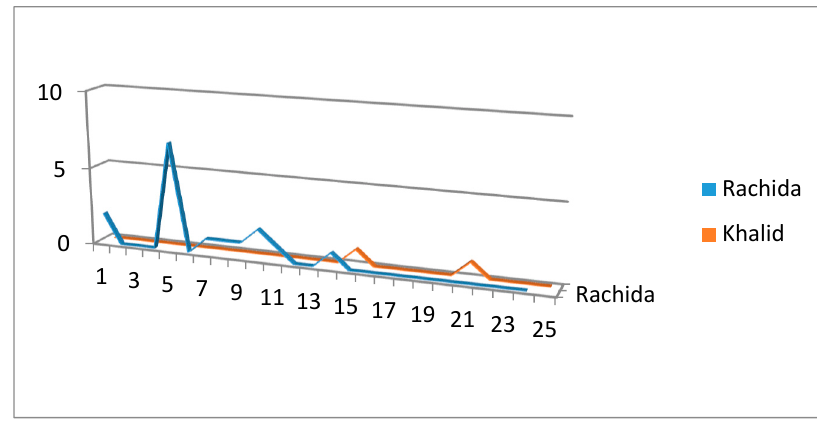
Figure 2. Number of occurrences of prosodic nominal assemblies (PNAs).The horizontal axis represents interview numbers; the vertical axis represents numbers of occurrences.